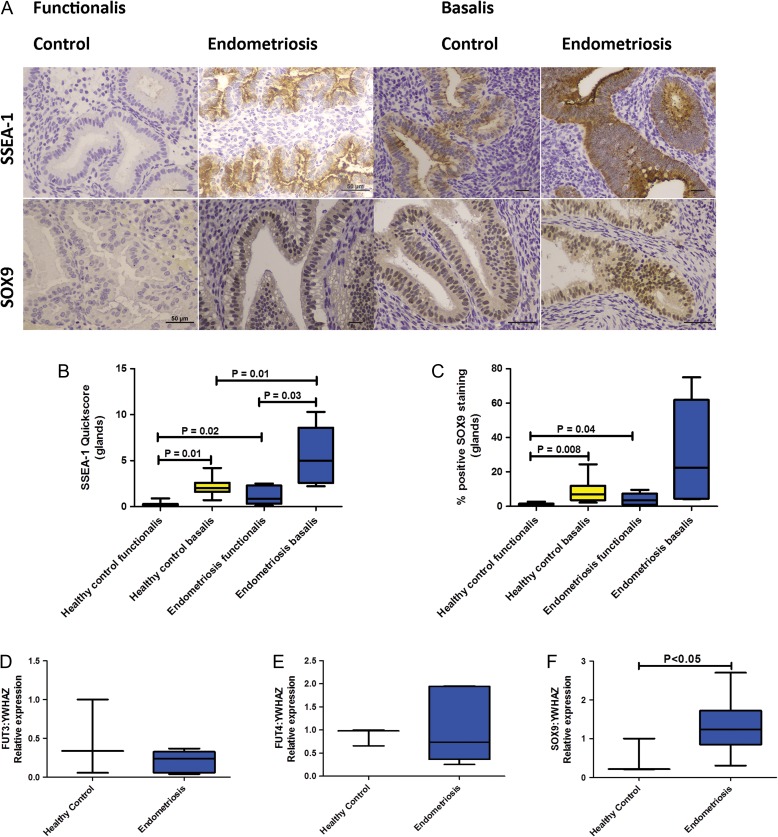

Immunohistochemical staining for endometrial SSEA-1 and SOX9 in normal fertile women without endometriosis (n = 14) and women with surgically confirmed symptomatic endometriosis (n = 10). Representative 400× micrographs showing the basalis and functionalis staining (A). Scale bar is 50 μm. Graphs showing immunohistochemical staining quickscores for SSEA1 (B) and SOX9 (C) protein expression in endometrial functionalis of healthy control women and endometriosis patients in the secretory phase of the cycle. Charts display median and quartiles with whiskers showing the range. Graphs depicting the enzymes likely responsible for catalysing the SSEA-1 epitope, FUT3 (D), FUT4 (E), and SOX9 ( F) mRNA expression in healthy fertile control tissue (n = 3) and endometriosis patient samples (n = 6). Charts display median and quartiles with whiskers showing the range but just median and range when n = 3.